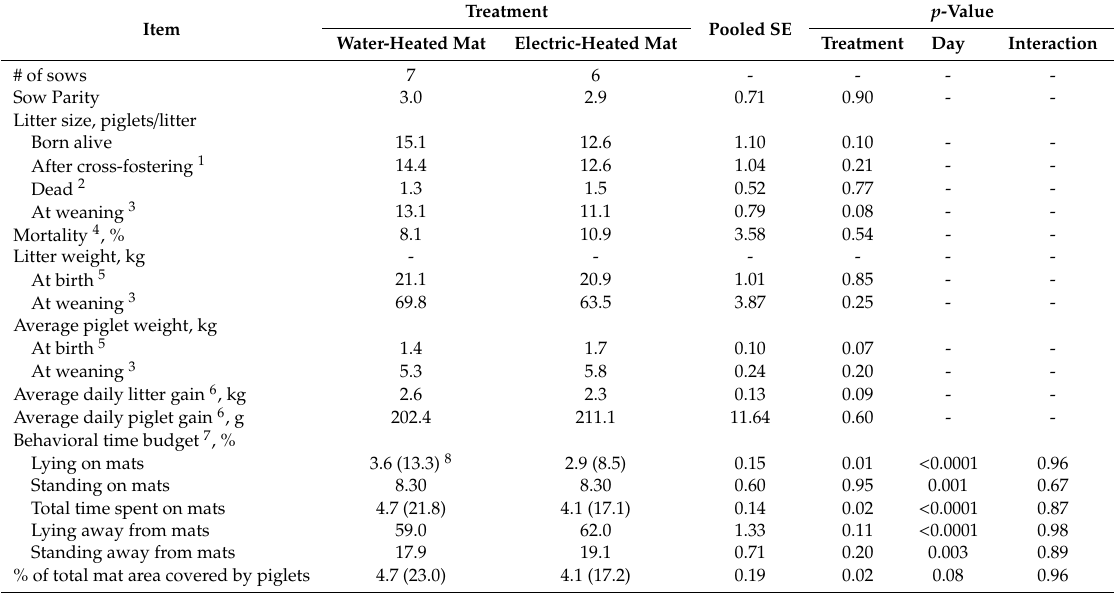
Table 5. Behavior and performance of piglets using water-heated mats or electric-heated mats (Trial